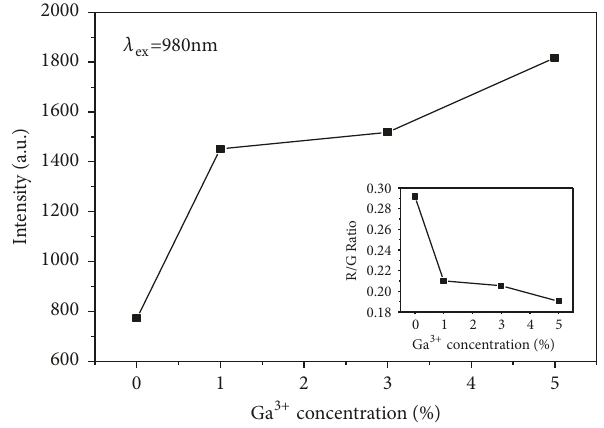
Ga x )O 3 : Er 3+ 0.01 , Yb 3+ 0.08 - x